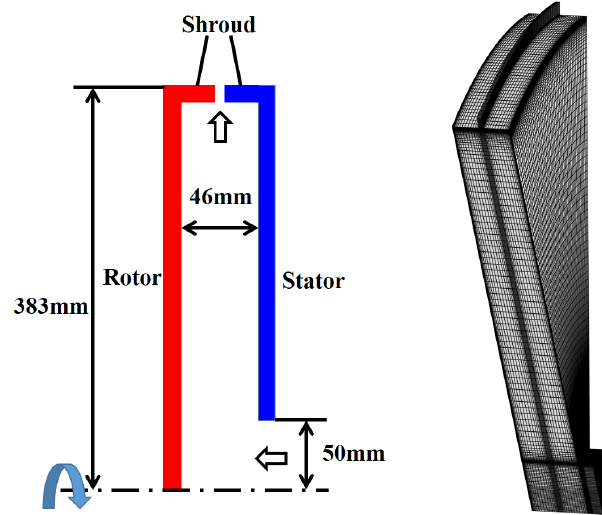
Figure 8. Experimental model [37] and mesh.